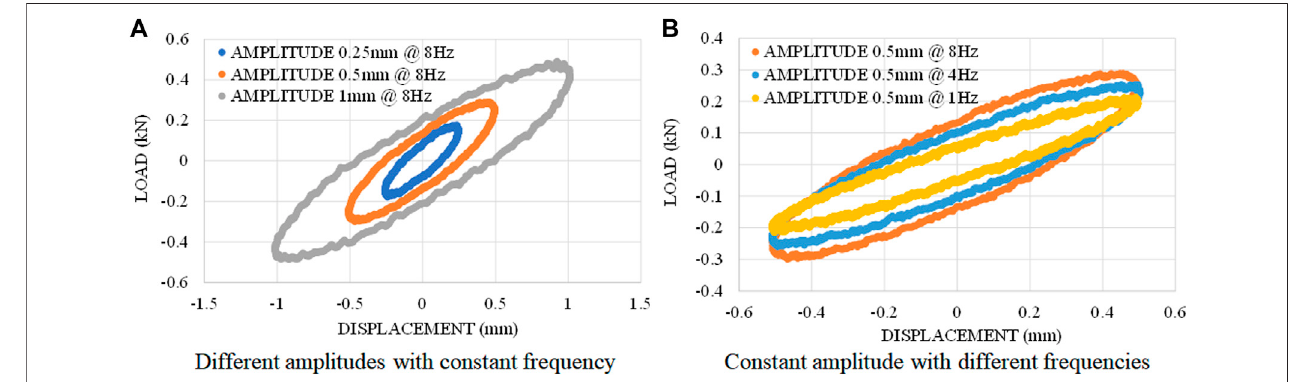
FIGURE 10 | Amplitude-dependency and frequency-dependency of load – displacement relationship of damper used in element test (damper B): (A) different amplitudes with constant frequency; (B) constant amplitude with different frequencies.